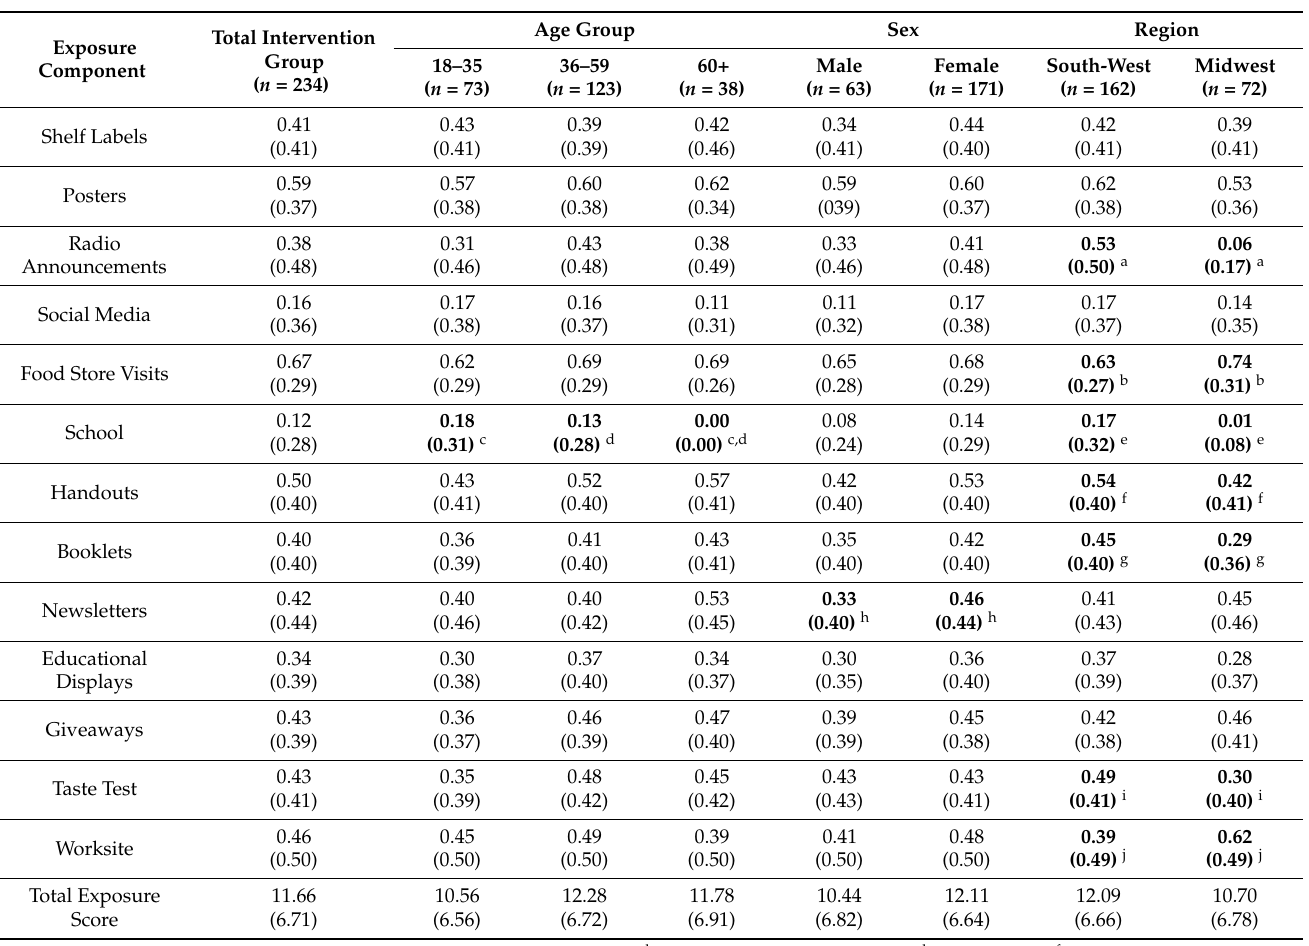
Table 2. Re-scaled component exposure scores (Mean (SD)) for 13 intervention components and the Total Exposure Score (Mean (SD), not re-scaled, range 0–28) to the OPREVENT2 intervention for the total intervention group, and by age, sex, and region.